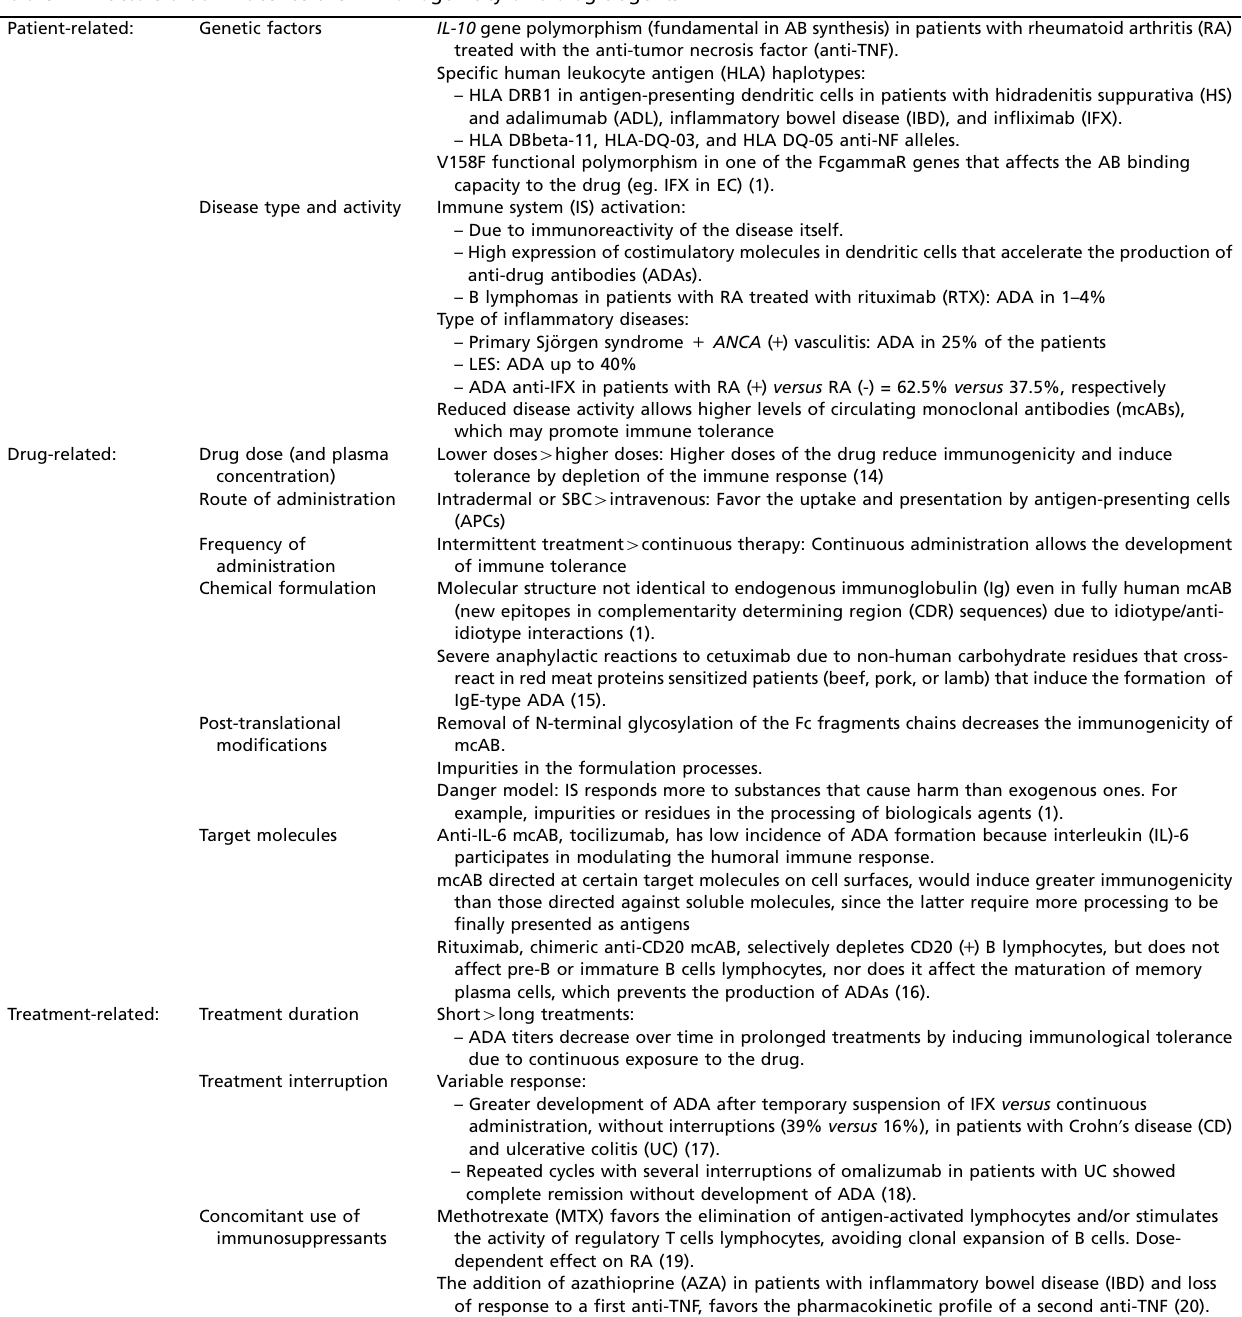
Table 1 - Factors that influcence the immunogenicity of biologic